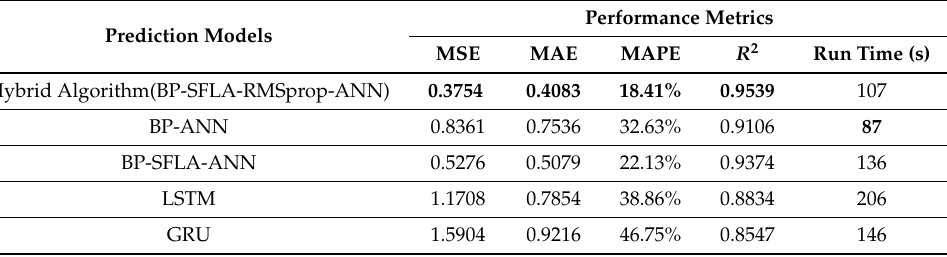
Table 2. The comparison of similar